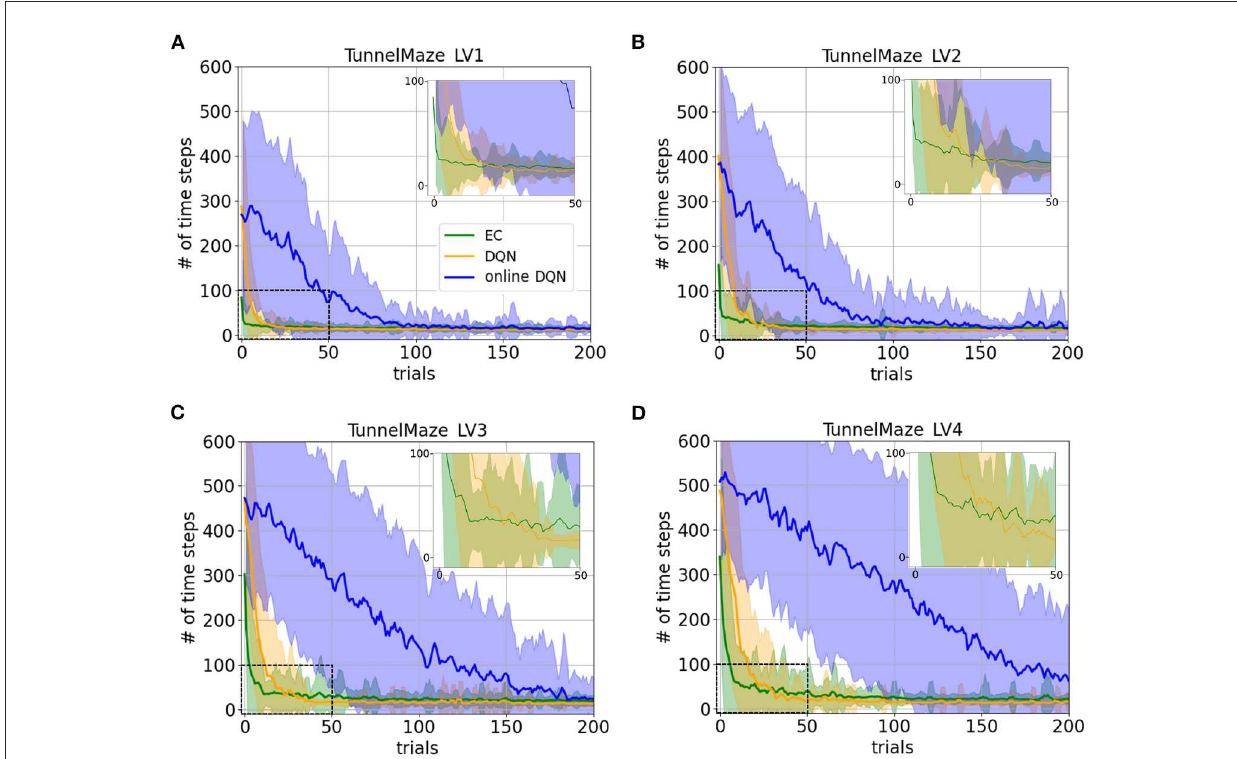
FIGURE5 Learning curves for the three learning paradigms in different environments, which are (A) Tunnel maze LV1, (B) Tunnel maze LV2, (C) Tunnel maze LV3, (D) Tunnel maze LV4. Each panel shows the number of time steps that the agent takes to find the goal in a specific trial. The curves and shaded areas indicate the mean and the standard deviation, respectively, obtained from 50 independent runs. The learning curves for the first 200 trials out of 500 trials are shown here because both EC and DQN have converged at this point. We also added insets of the learning curves for the first 50 trials to show details where DQN starts outperforming EC. Although the curves for online-DQN do not fully reach asymptotic performance in panel (D) , most agents still managed to find the solutions at the end of the simulation (500 trials). Model-free Episodic Control (EC) represents one-shot learning, Deep Q Learning with memory replay (DQN) represents replay learning, and online Deep Q Learning (online DQN) represents online